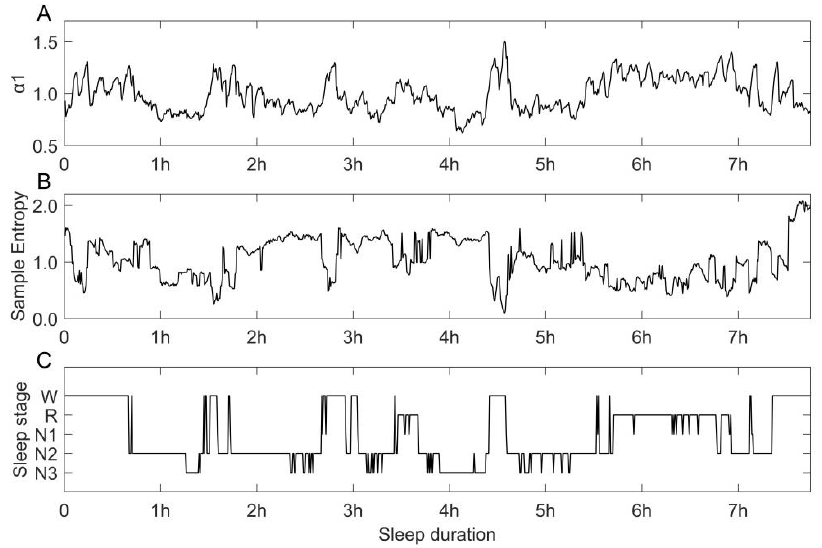
Figure 1. Variations in HRV parameter ɑ 1, sample entropy and sleep stages in a whole night of a subject in SHHS1DB. (A-C) show the corresponding graph of ɑ 1, sample entropy and sleep